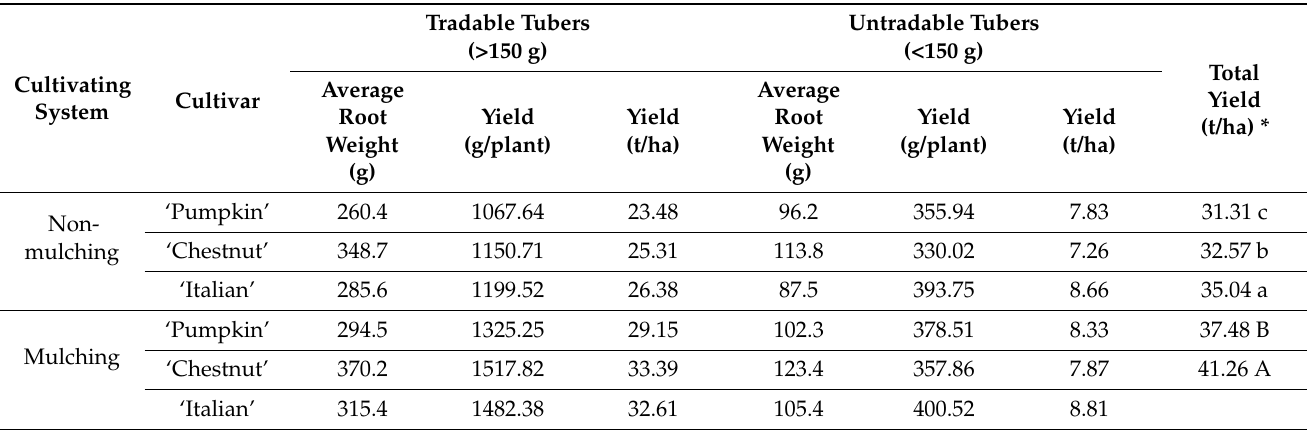
Table 2. The effect of cultivar on the production parameters of the sweet potato.